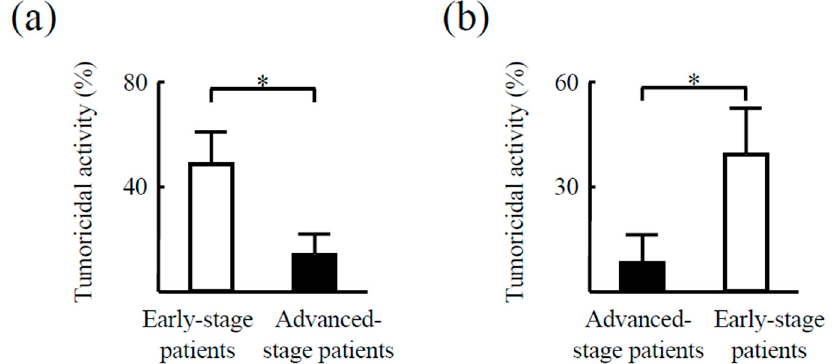
Figure 5. Tumoricidal activity of CD14 + cells depends on cancer progression. CD14 + cells isolated from patients before and after tumor regression were examined for cytotoxic activity against HepG2 cells by lactate dehydrogenase (LDH) release assay. ( a ) Changes related to tumor progression from early stages to advanced stages ( n = 5). ( b ) Changes related to tumor progression from advanced stages to early stages ( n = 5). * p < 0.05.